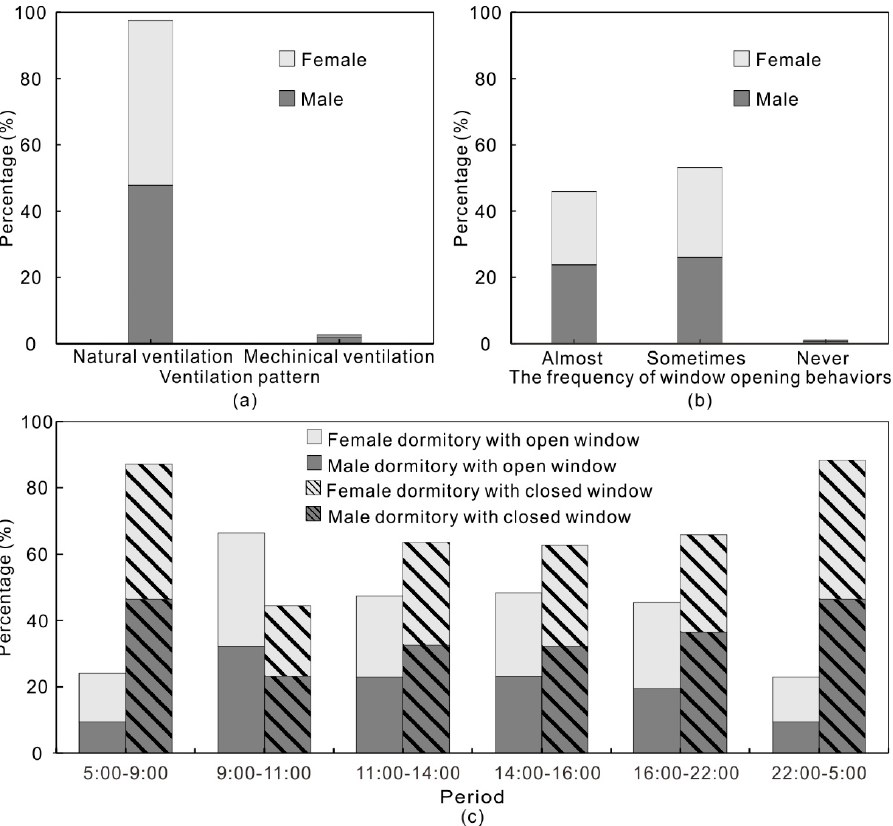
Figure 4. ( a ) Ventilation pattern in surveyed dormitories; ( b ) The frequency of window opening behaviors in dormitory; ( c ) The Period of window opening behaviors in